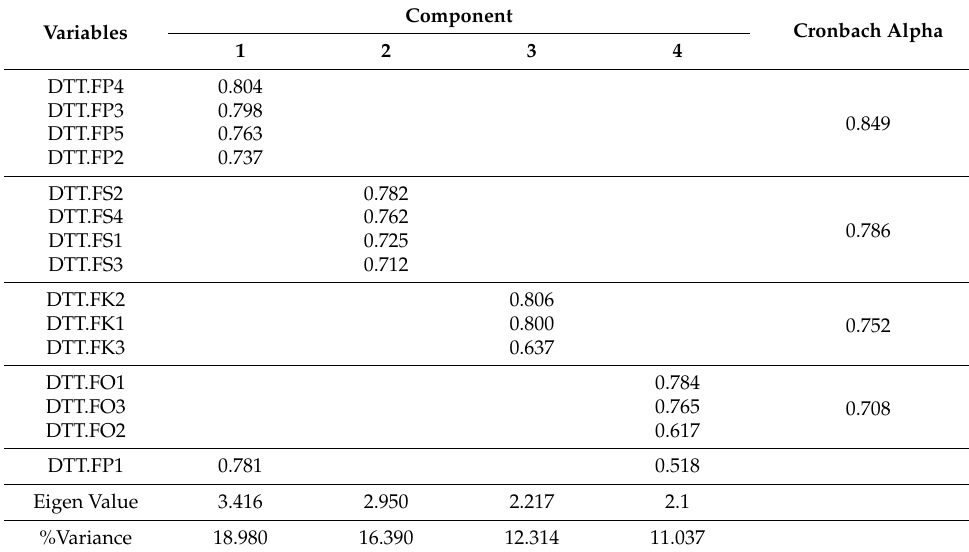
Figure 3. Scree plot. Table 3. EFA results after